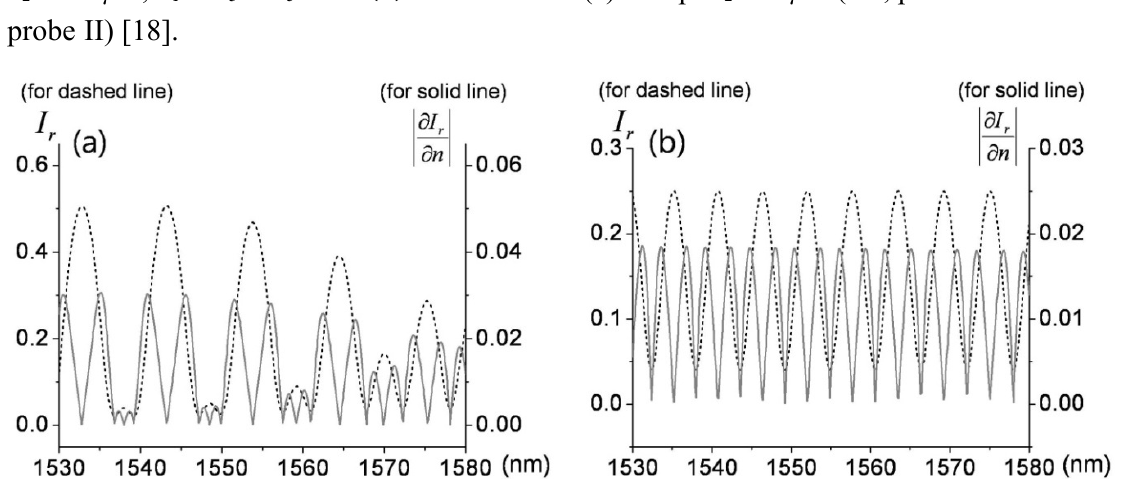
= h = 50 μ m , 1 3 = 0 μ m ( i.e. , probe V becomes 2